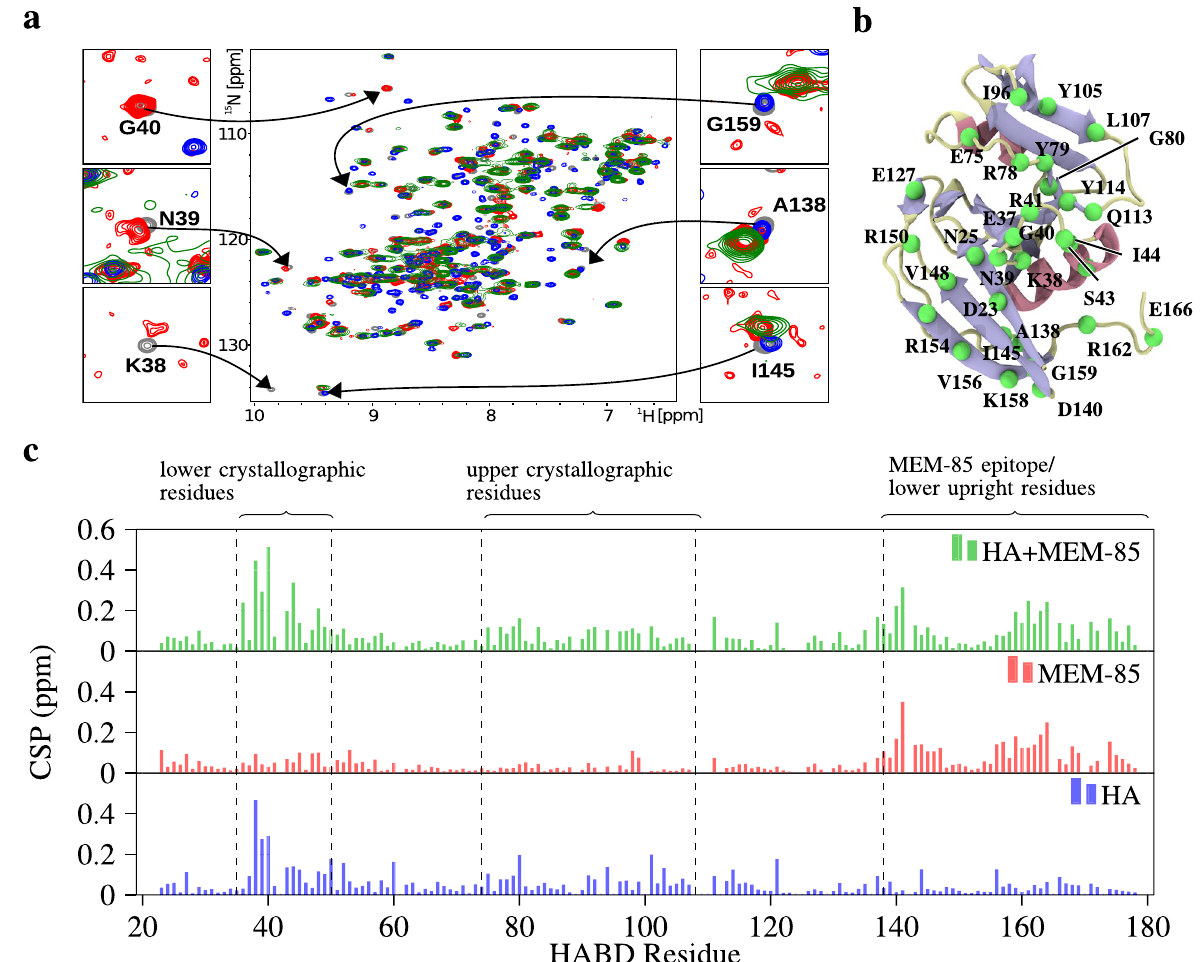
Figure 4. NMR confirms the simultaneous binding of scFv MEM-85 and hyaluronate to CD44-HABD. ( a ) 15 15 15 1 2D N/ H HSQC spectra are shown for free N-CD44-HABD (grey), N-CD44-HABD in complexes with hyaluronate hexamer (threefold molar excess; blue), scFv MEM-85 (twofold molar excess; red), and both scFv MEM-85 (twofold molar excess) and hyaluronate hexamer (threefold molar excess; green). Details of the signals are shown for selected residues from the hyaluronate-perturbed (left) and antibody-perturbed (right) regions of CD44-HABD. ( b ) Illustration of the CD44-HABD (PDB:1UUH), highlighting the residues mentioned in the main text. From the residues, only the C α atom is depicted (green). Coloring of the protein is based on secondary structure, such that coils are pale, sheets are blue, and helices are red. ( c ) Histograms of the minimal 15 combined chemical shift perturbation (CSP) versus the protein sequence are shown for N-CD44-HABD in complex with hyaluronate hexamer (blue), scFv MEM-85 (red), and both scFv MEM-85 and hyaluronate hexamer